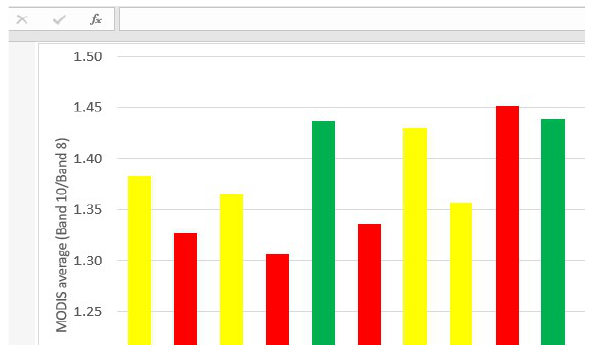
Figure 13. Median February MODIS and honey harvest data